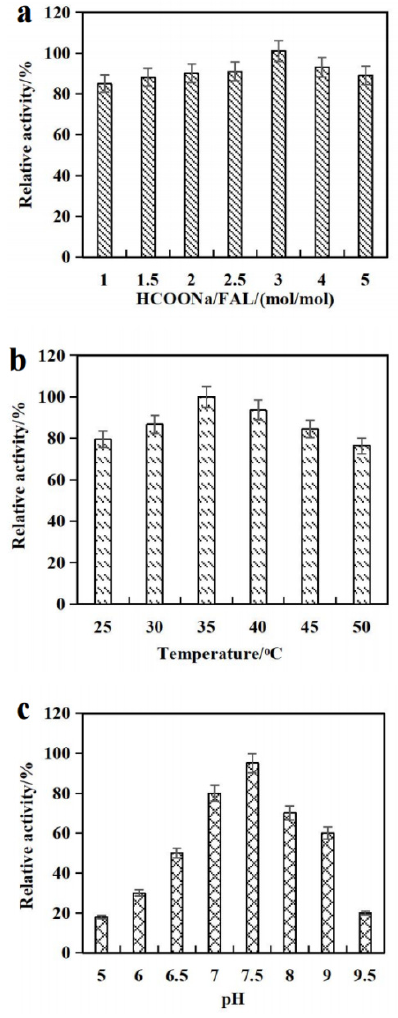
Figure 2. The effect of HCOONa-to-FAL molar ratio on the FAL-reducing activity ( a ); The effect of bioreaction temperature on the FAL-reducing activity ( b ); The effect of bioreaction pH on the FAL-reducing activity ( c ).